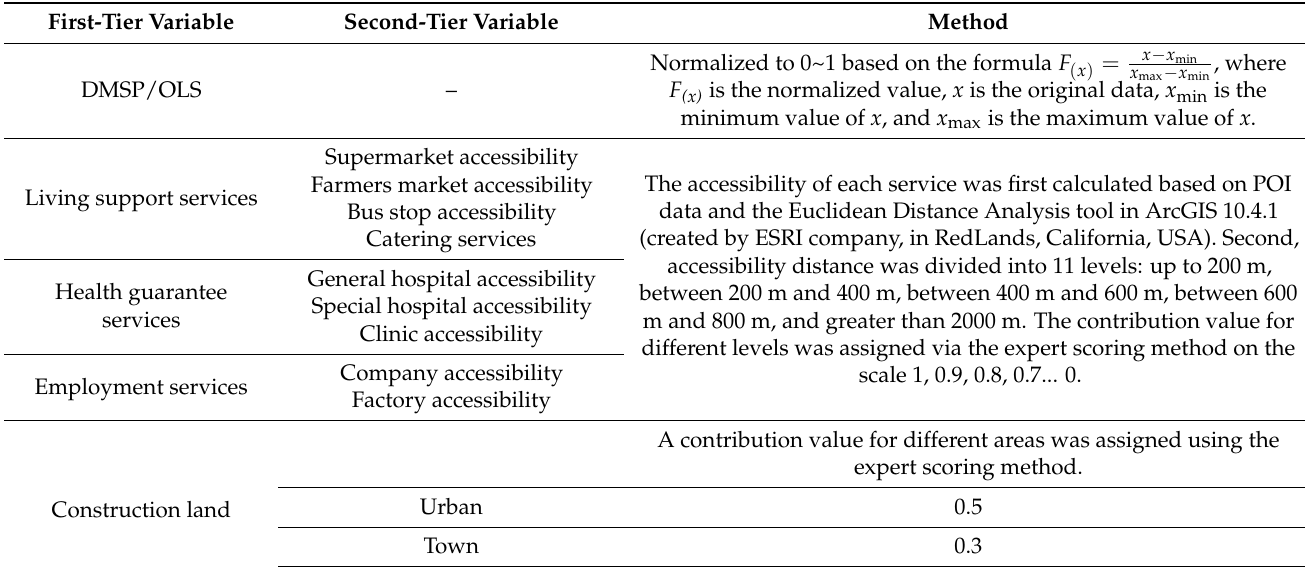
Table 1. Contribution coefficients of primary student spatial